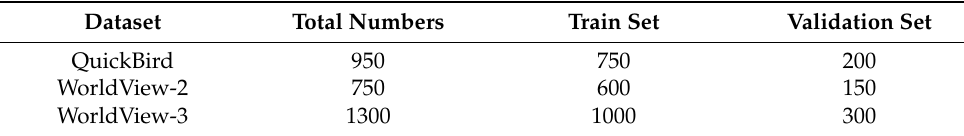
Table 2. Size of the training and testing sets for the satellite